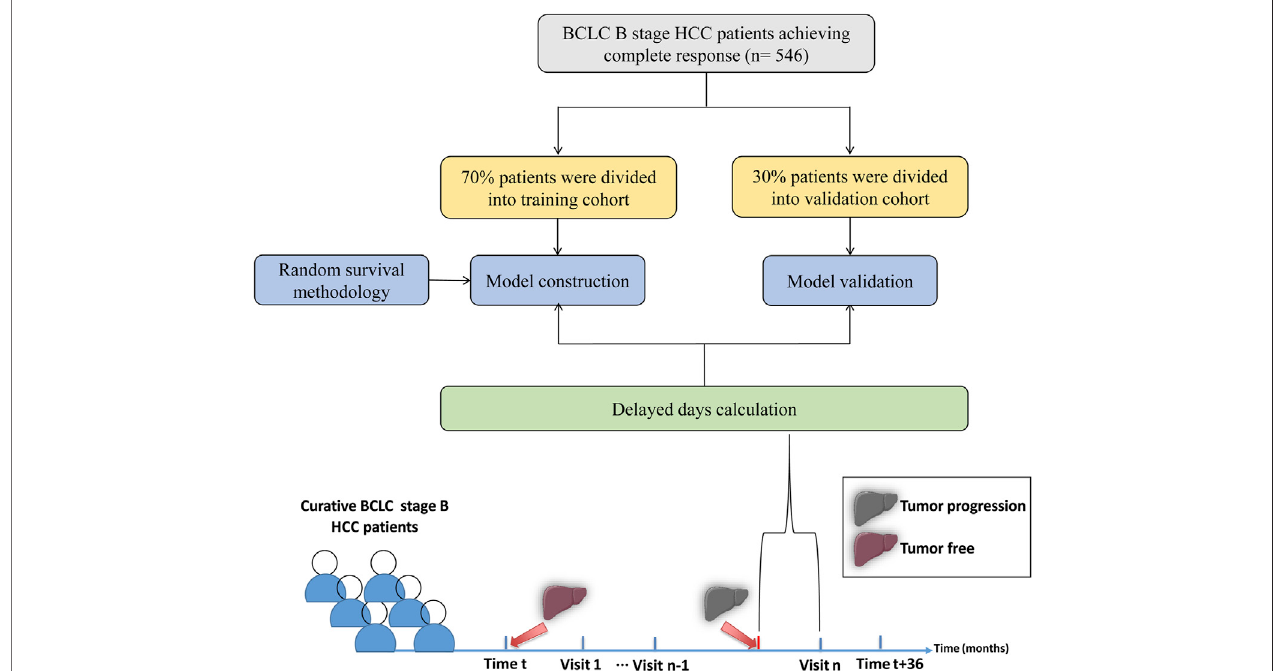
FIGURE 1 | General design of the present